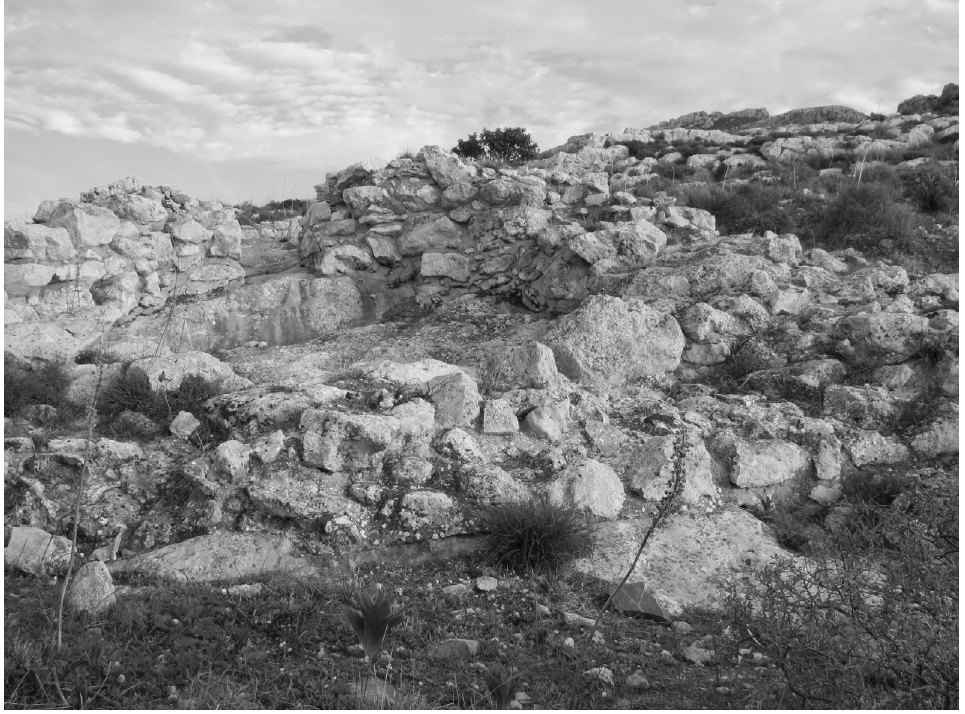
Figure 4. The circular chamber of Tholos A, built on a ledge of bedrock that slopes down towards the west (Flouda, 2011, pl. XXXVa; reproduced by